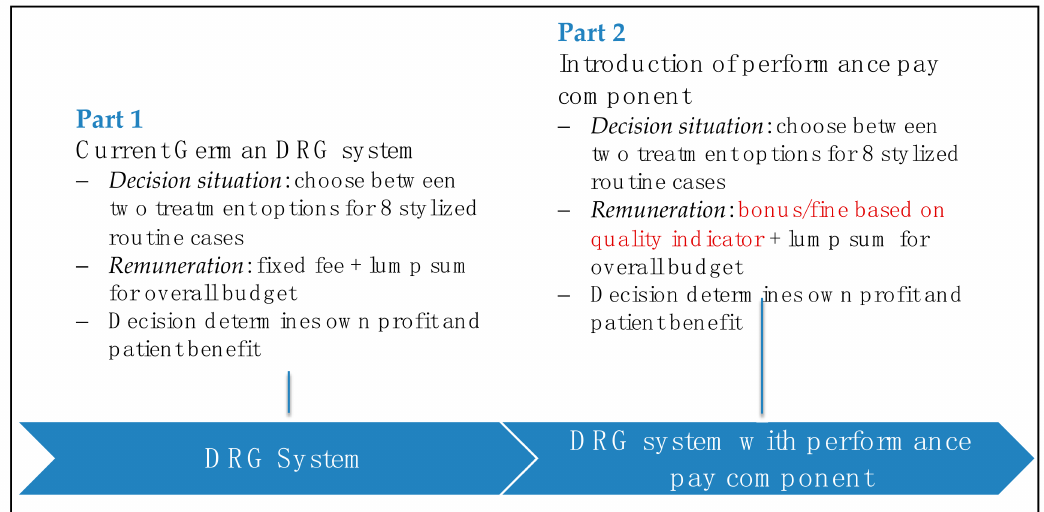
Figure 2. Summary of experimental design and payment